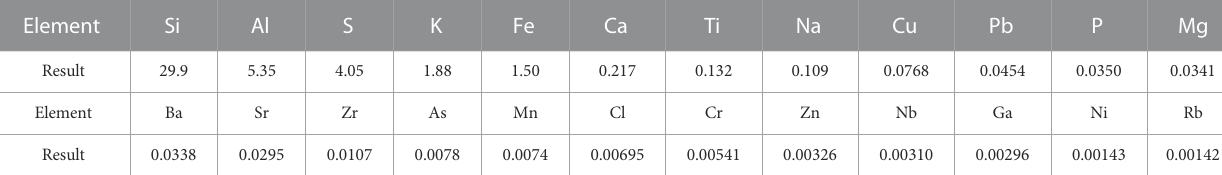
TABLE 2 Chemical compositions of the low-grade copper sul fi de tailings by XRF analysis (wt%). Element